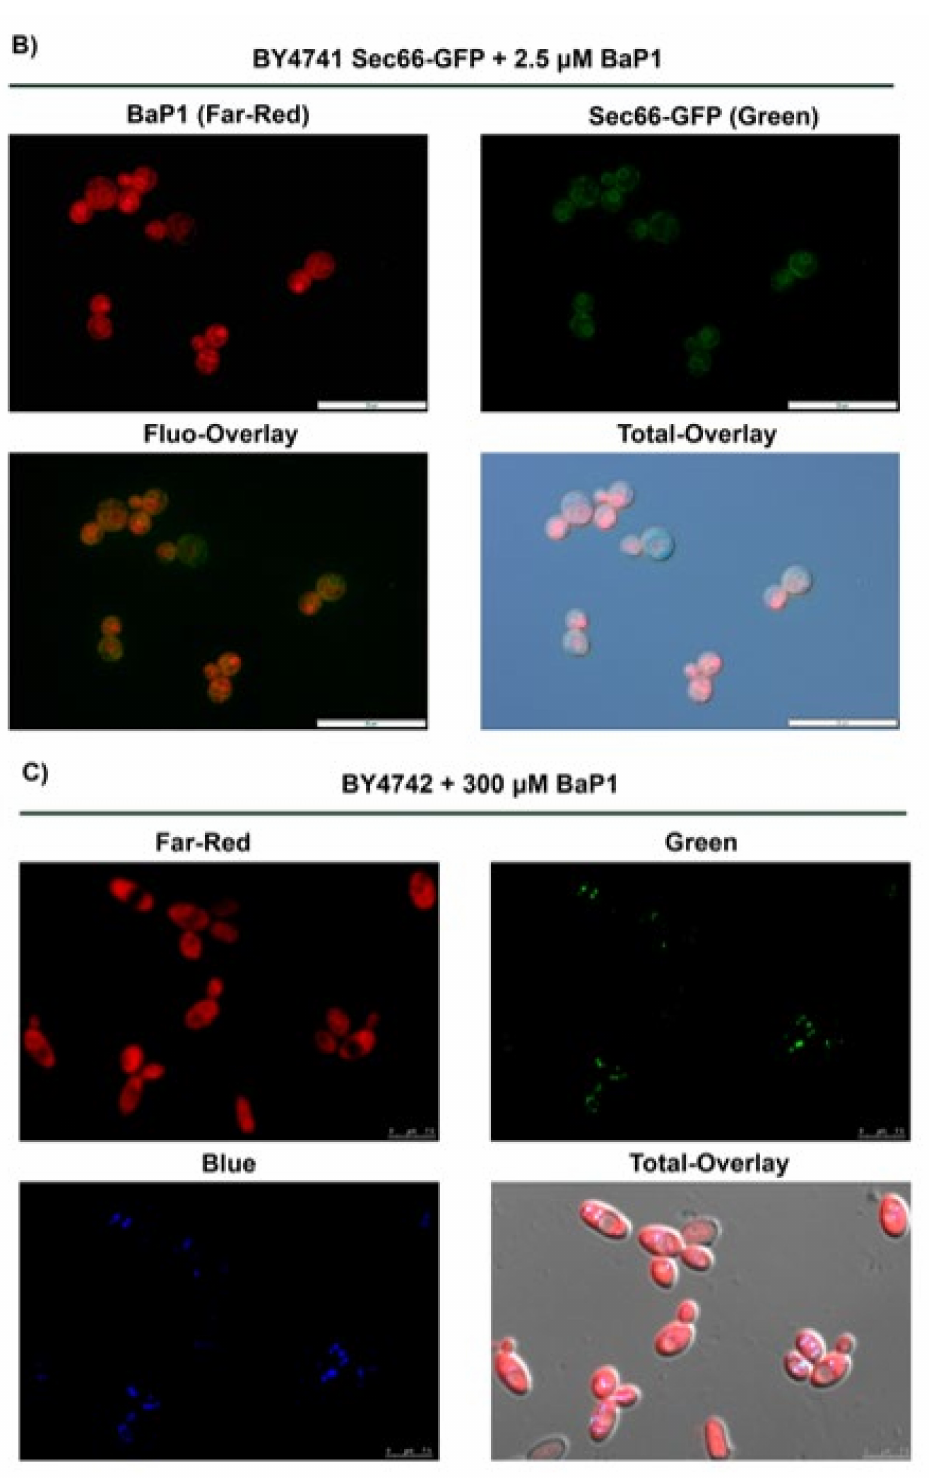
Figure 5. BaP1 intracellular distribution for concentrations of 2.5 µ M and 300 µ M. ( A ) Fluorescence microscopy images of W303-1A-pDF01-VBA1-YEGFP cells after incubation with BaP1 (2.5 µ M). ( B ) Fluorescence microscopy images of BY4741- SEC66-GFP cells after treatment with BaP1 (2.5 µ M). ( C ) Fluorescence microscopy images of BY4742 cells after incubation with BaP1 (300 µ M). Samples were stained in PBS 1 × at room temperature and visualized by epifluorescence microscopy after 5 min with a 100 × oil immersion